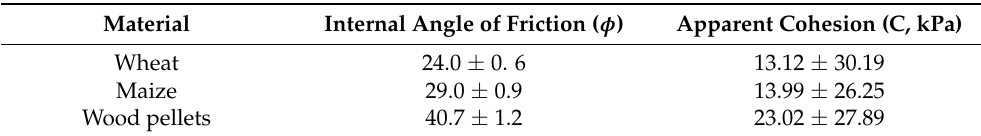
Table 1. Mean ± standard deviation for the internal angle of friction and the apparent cohesion of the tested materials.